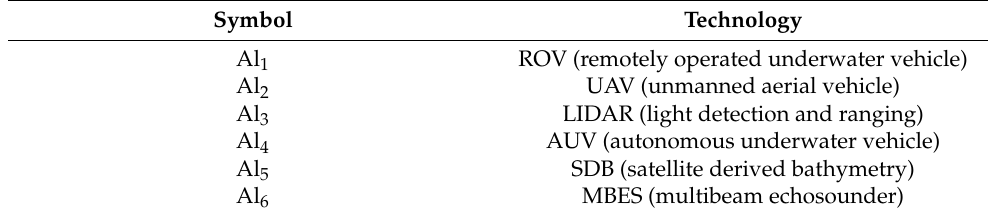
Table 3. Available technologies.